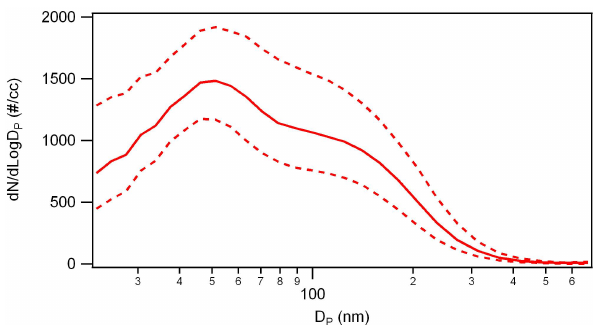
Fig. 4. Particle size distribution as measured with the DMPS at the GAW tower. The graph shows median (solid line) and inter-quartile range (dashed line) for the period 21st June to 24th July